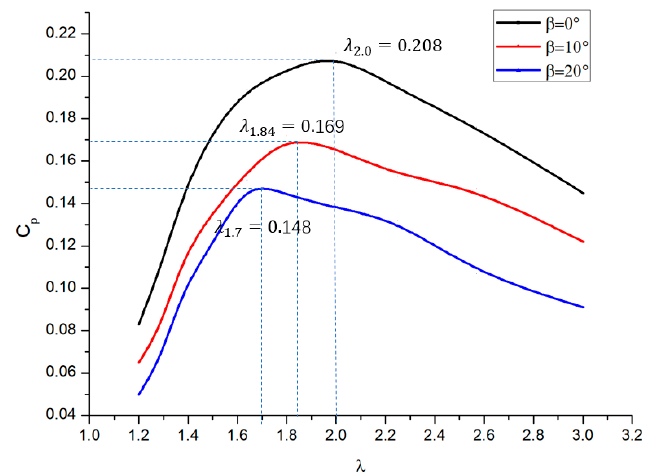
Figure 12. The relationship between the energy utilization coefficient and the velocity ratio at different inclination angles.